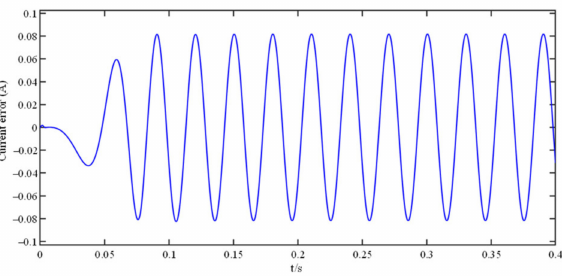
Figure 23. The current error graph when R = 0.0714 Ω